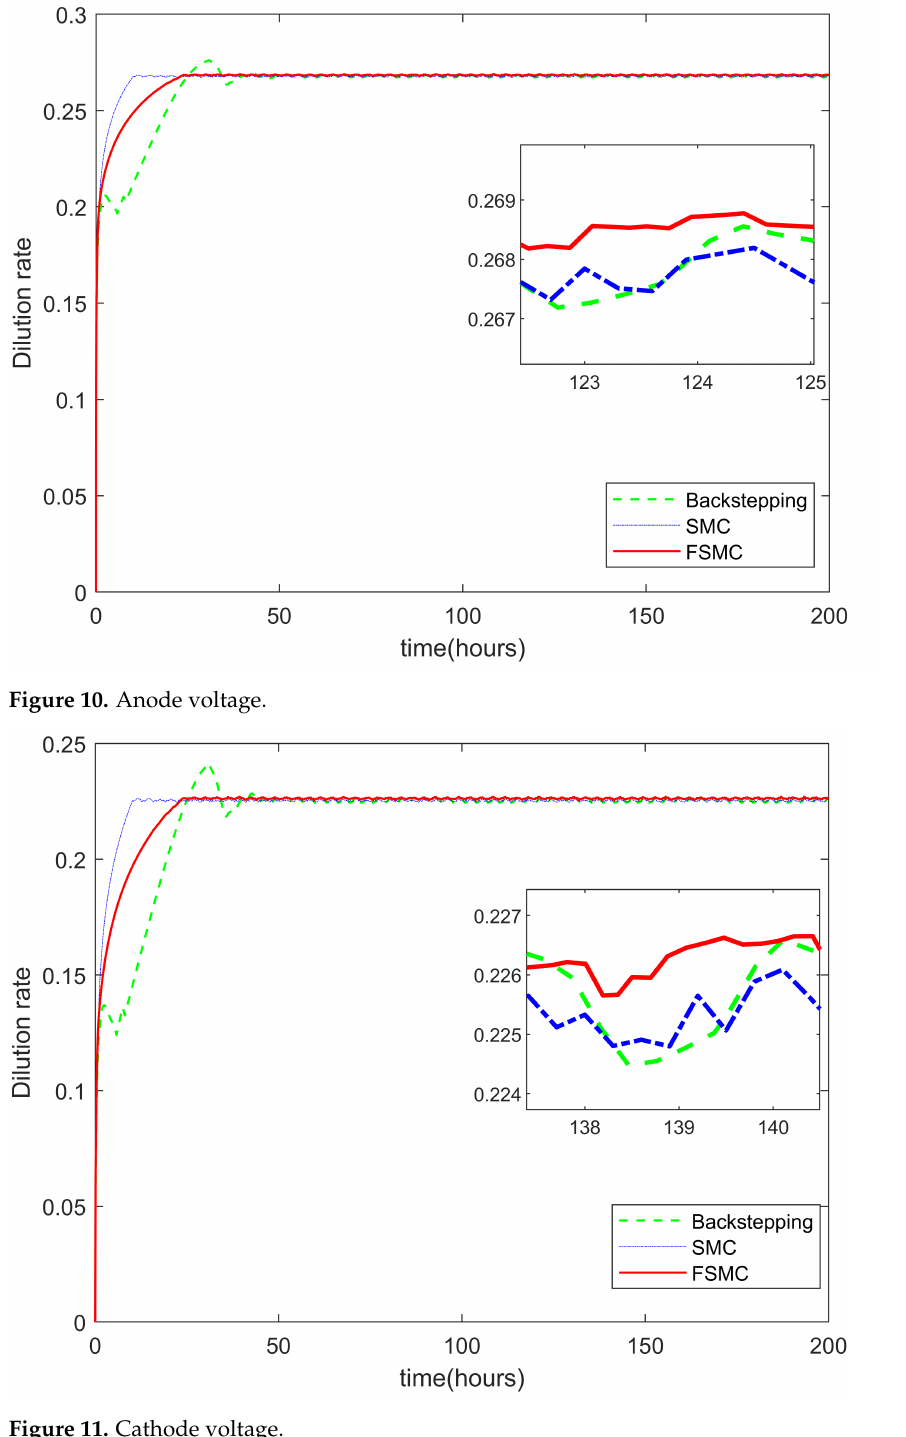
Figure 11. Cathode